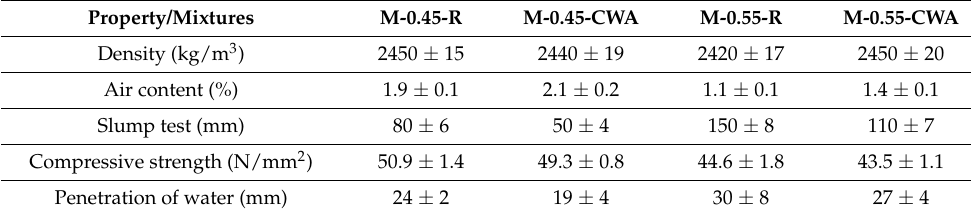
Table 4. Test results of fresh and hardened concrete